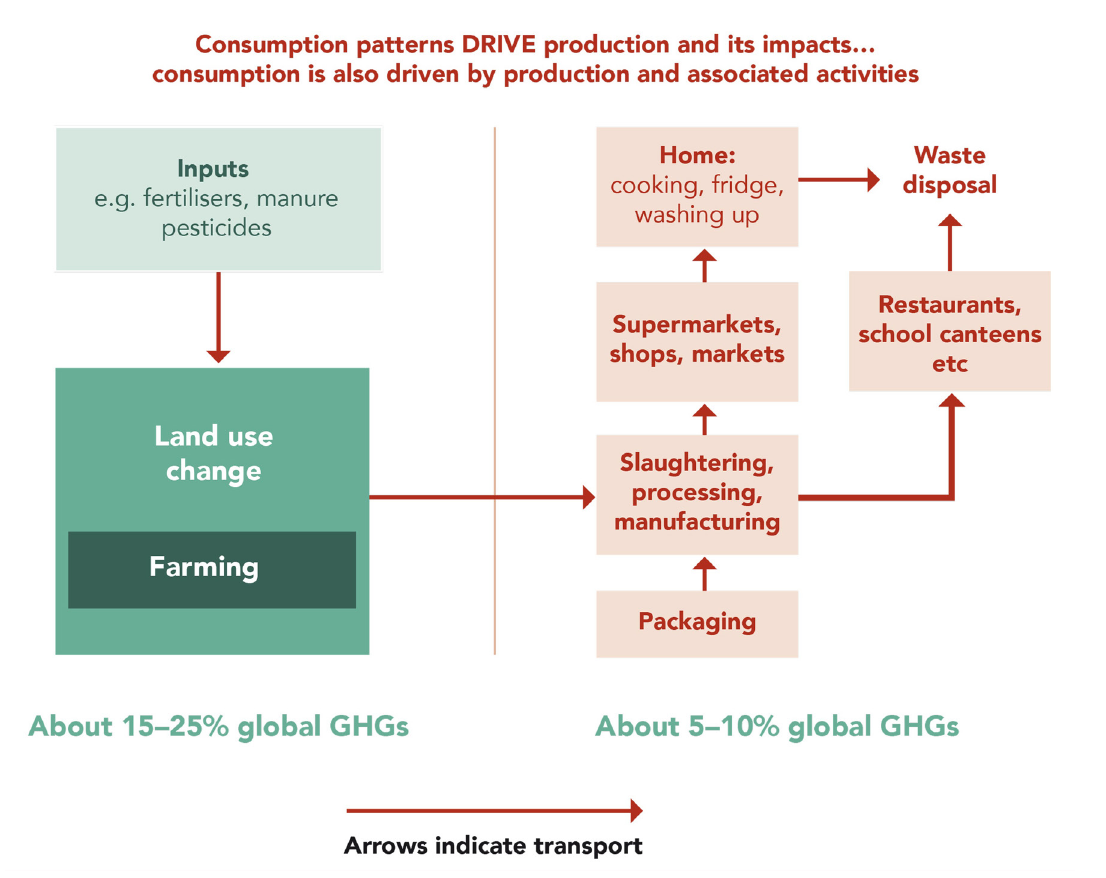
Figure 1: The food system’s contribution to global greenhouse gas emissions